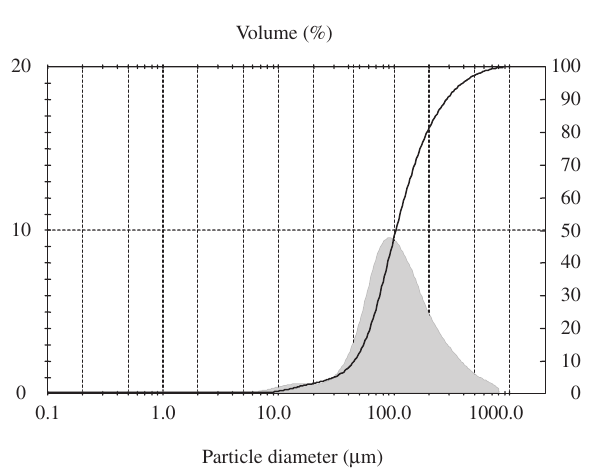
Table 5. Effects of chitosan solution flow rate (CSFR) and nitrogen pressure (NP) parameters on mean particle size (MPS) and mean standard deviation (MSD).